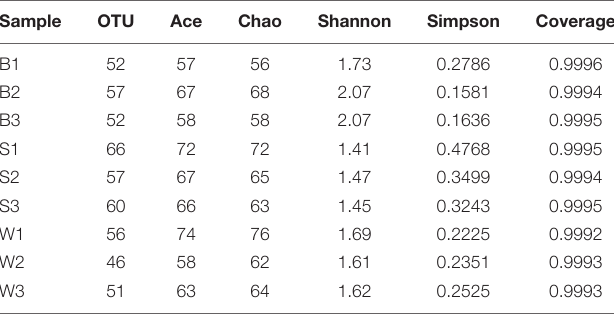
TABLE 1 | Microbial community richness and diversity indices of the 16S rRNA sequences for clustering at 97% sequence similarity from nine samples in three different types of starters.